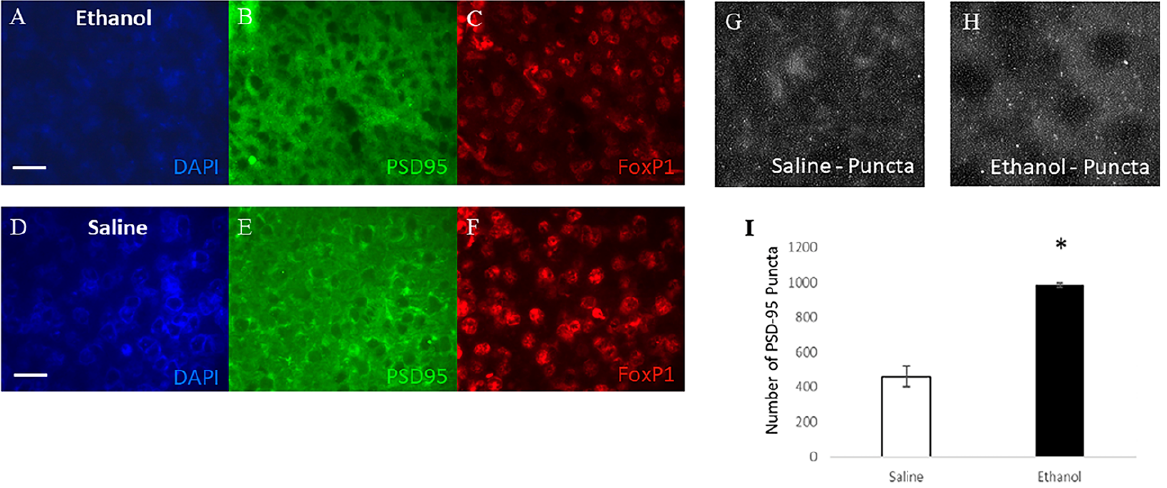
Figure 5. Ethanol treatment increases the level of PSD-95 found in the striatum 24 h after exposure. ( A – F ). Immunofluorescence images taken at 400 × magnification; images left to right of DAPI, PSD-95, and FoxP1 staining. DAPI labels nuclei, and FoxP1 is a marker for MSNs. ( A – C ) depict ethanol-treated animals, while D–F depict saline-treated animals (Scale bar = 50 µ m). ( G – H ) depict examples of PSD-95 immunofluorescence images used for counting puncta. ( I ). Quantification of PSD-95 puncta in immunofluorescence images (461.46 ± 58.38 saline, 984.17 ± 10.0 ethanol, *: p = 0.010).